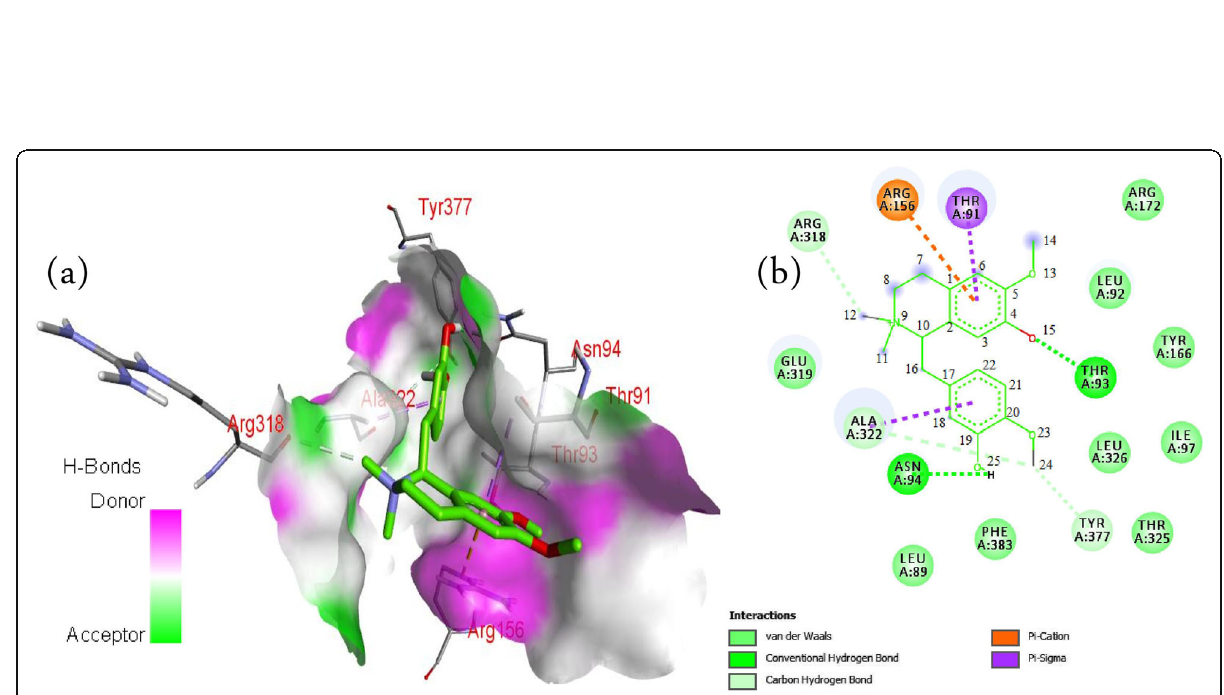
Fig. 5 Interaction of tembetarine with beta 1 adrenergic receptor. ( a ) 3D pose of tembetarine ( b ) 2D plot of tembetarine-beta 1 adrenergic receptor